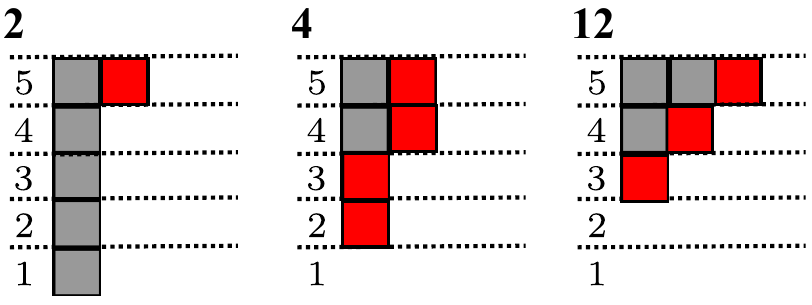
Figure 7 . The tableaux for the elementary coefficients: a